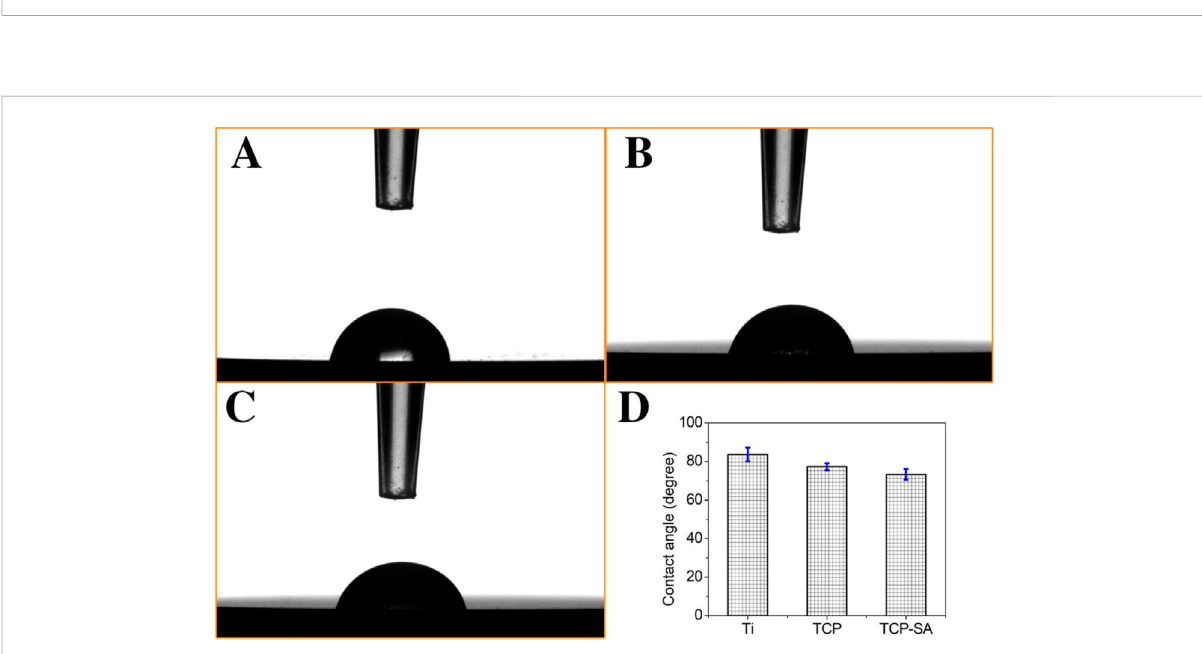
FIGURE 5 Static contact angles for each group of samples, and (A) Ti, (B) TCP, (C) TCP-SA and (D) bar chart of contact